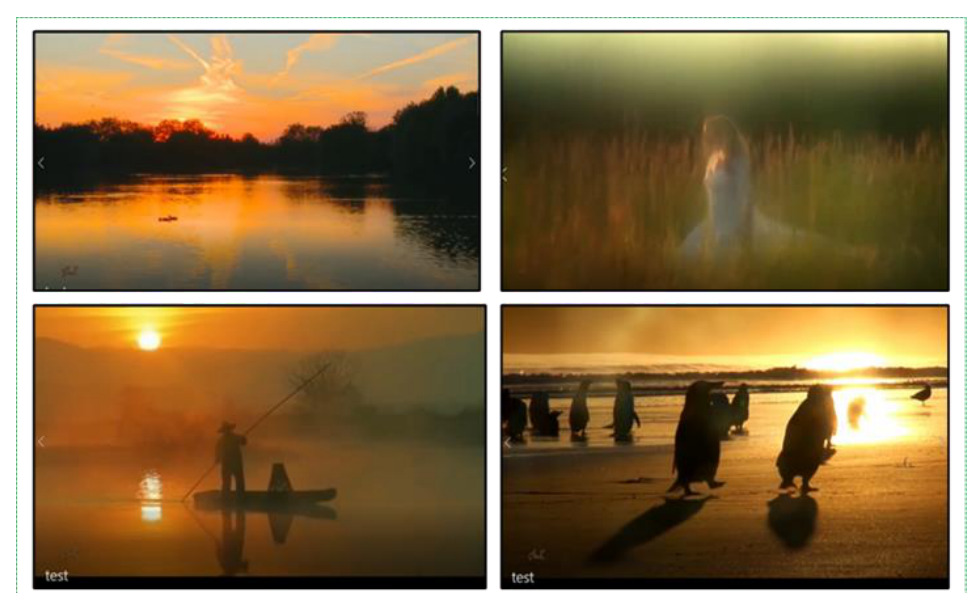
Figure 8. Example of sunlight images in the dataset.